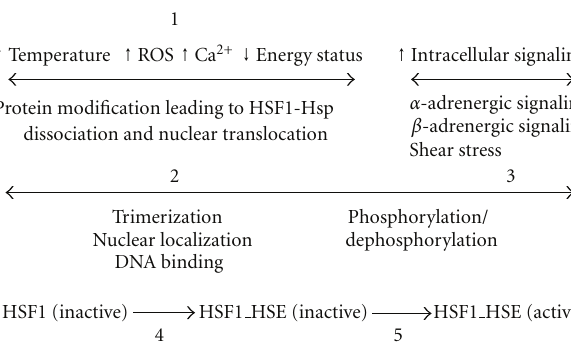
Figure 1: Schematic representation of activation of HSF1 with exercise and accompanying increases in vascular stress. Exercise initiates a number of factors, including elevations in temperature, reactive oxygen species (ROS), intracellular calcium (Ca 2+ ), and decreased energy status [1], which may result in intracellular protein modification leading to dissociation of the heat shock transcription factor (HSF1) and heat shock proteins Hsp in the cytoplasm [2]. In addition, exercise activates adrenergic and shear stress intracellular signaling pathways [3]. Consequently HSF1 trimerizes and binds to heat shock elements (HSE) of nuclear DNA [4], whereupon specific phosphorylation/dephosphorylation events lead to a heat shock response [5]. Adapted from Noble, Melling, and Milne